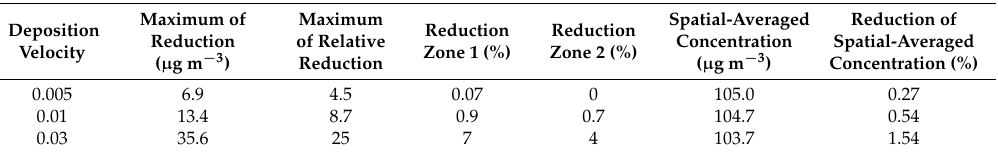
Table 3. Concentration reduction for vegetation with LAD = 0.1 m 2 m − 3 and 3 different deposition velocities (Current-1 scenarios).